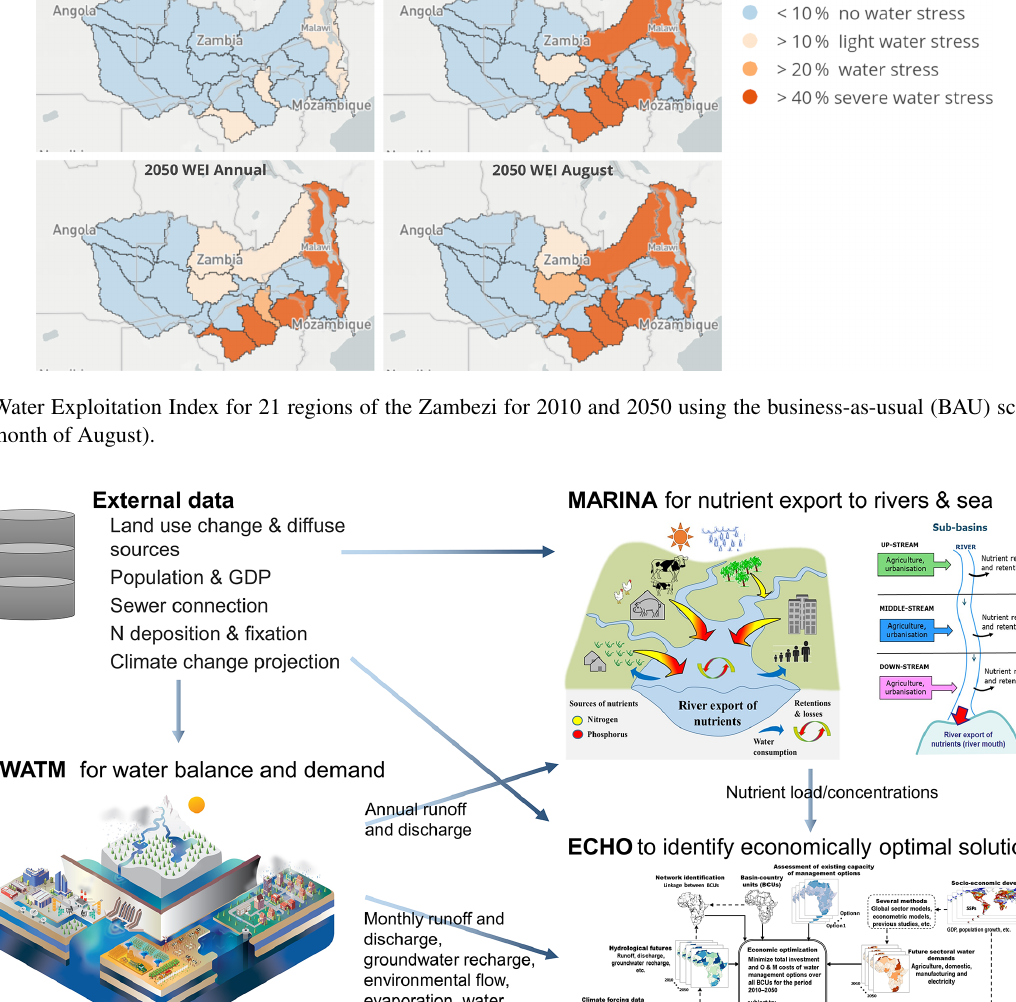
models for assessing and evaluating water management